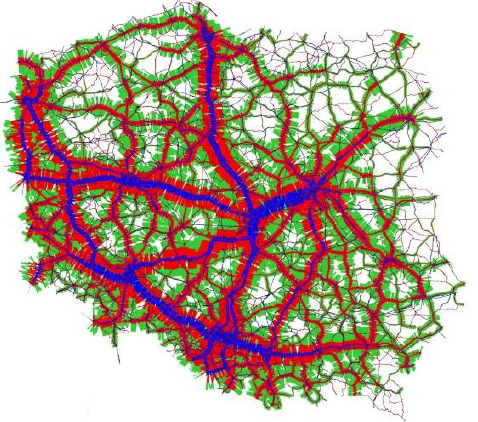
Fig. 5. The level of emissions of harmful compounds by passenger transport in 2025 in g/km (legend: blue line – HC, red line – CO, green line – NO x )